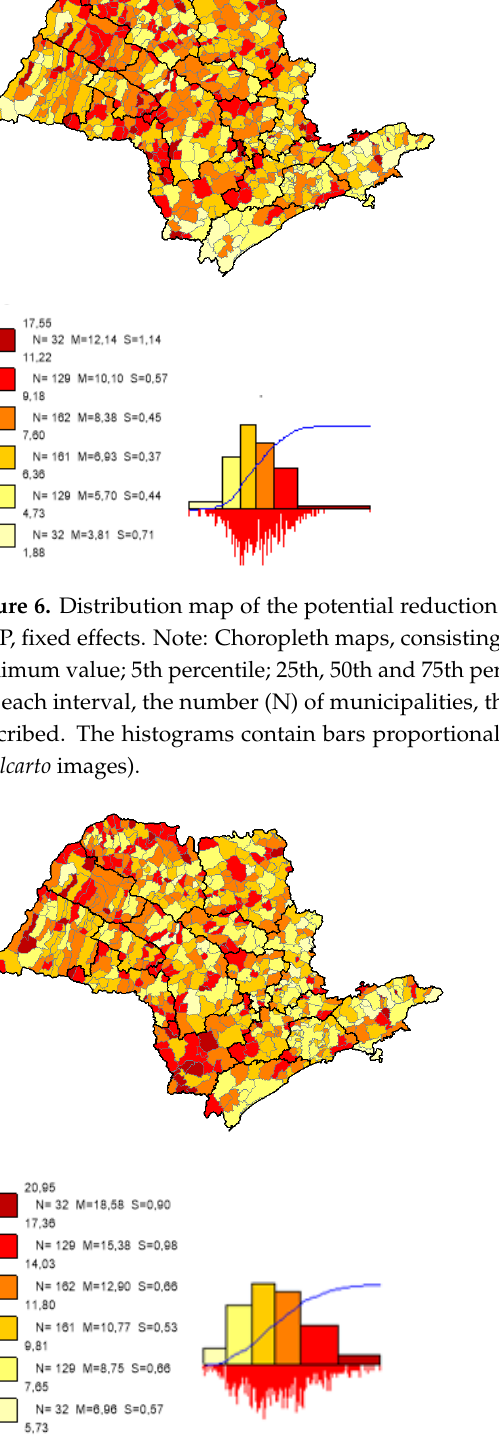
Figure 7. Distribution map of the potential reduction in the IM rates in the municipalities of the state of SP, DEA method. Note: Choropleth maps, consisting of six divisions, using the following limits—minimum value; 5th percentile; 25th, 50th and 75th percentiles; 95th percentile and maximum value. For each interval, the number (N) of municipalities, their mean (M) and standard deviation (S) are described. The histograms contain bars proportional to the number of localities in each division ( Philcarto images).